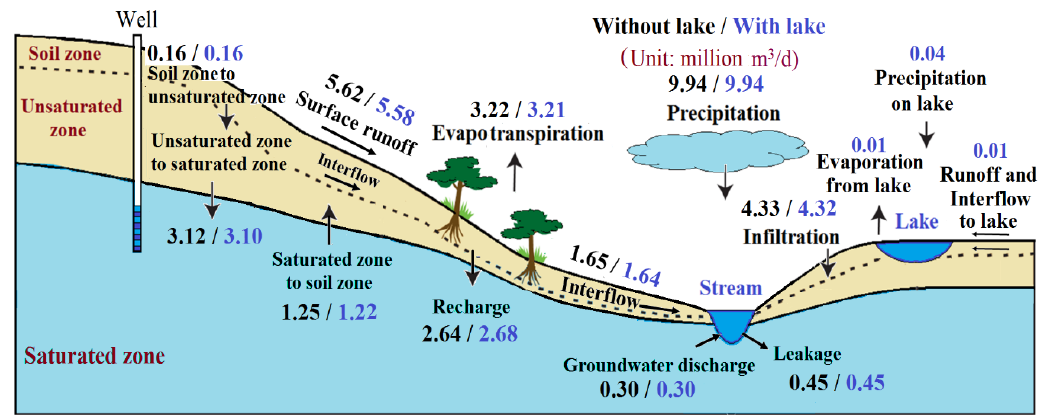
Figure 15. The simulated volumetric fluxes of water cycle components based on the presence of an artificial recharge lake in the simulation area. Note that the values with black and blue colors represent the simulated flow rates without and with the artificial lake.